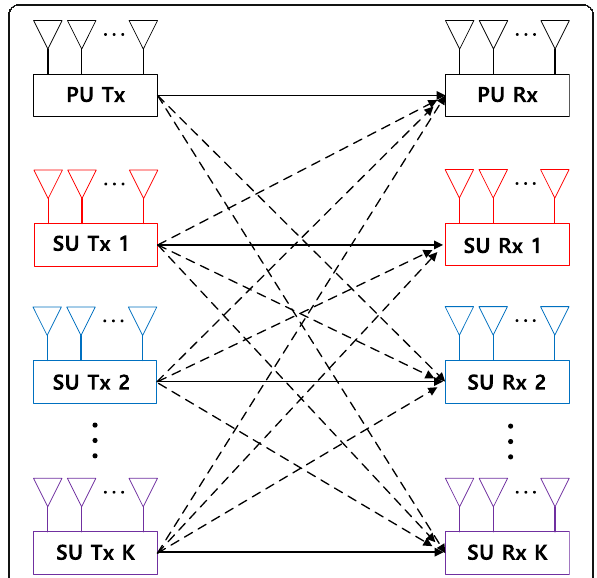
Fig. 1 General interference alignment in CR system. The PU participates in the interference alignment of the transceiver pairs of the CR system and they can transmit data without interfering with each other transmitter. All the SUs share the transmission resource with the PU at the same time. Each transmitter and re-